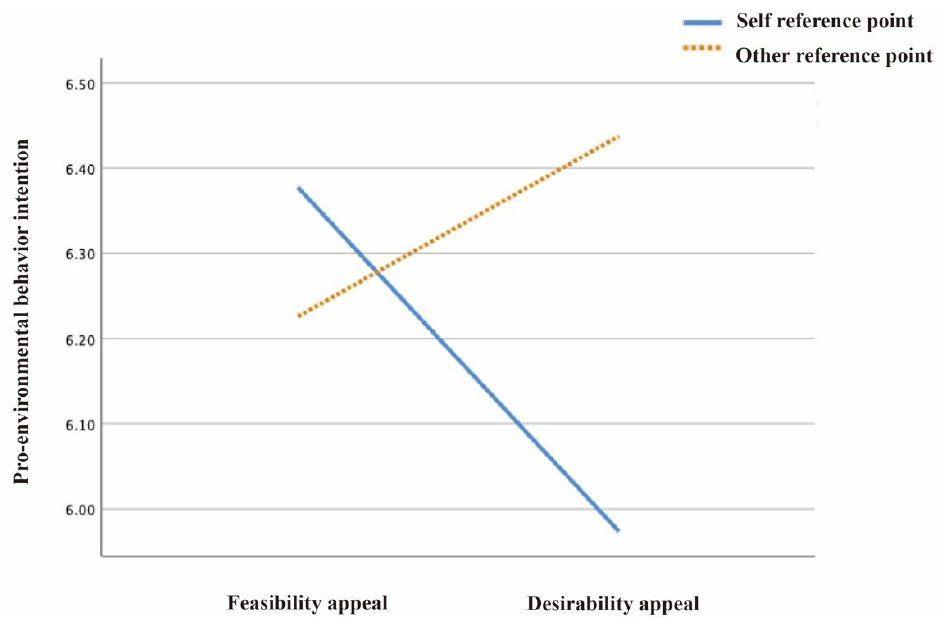
Figure 4. The effect of text appeals on pro-environmental behavioral intentions, assessed by image reference point. reference